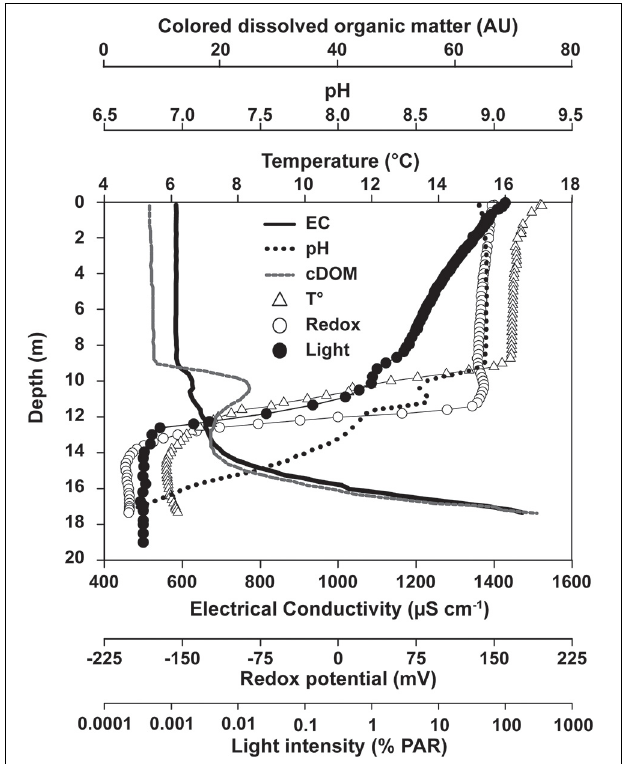
FIGURE 2 | Depth profiles of physico-chemical conditions in the water column of Lake La Cruz. Profiles were recorded during summer stratification conditions